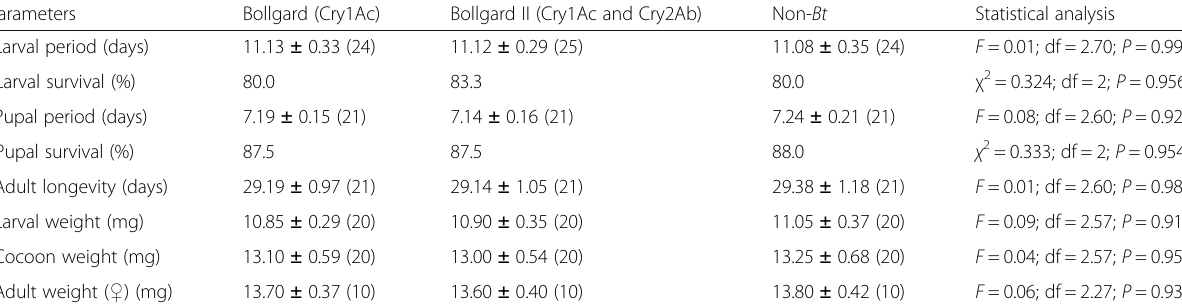
Table 1 Development time, survival and weight of Chrysoperla zastrowi sillemi fed on Phenacoccus solenopsis reared on Bt and